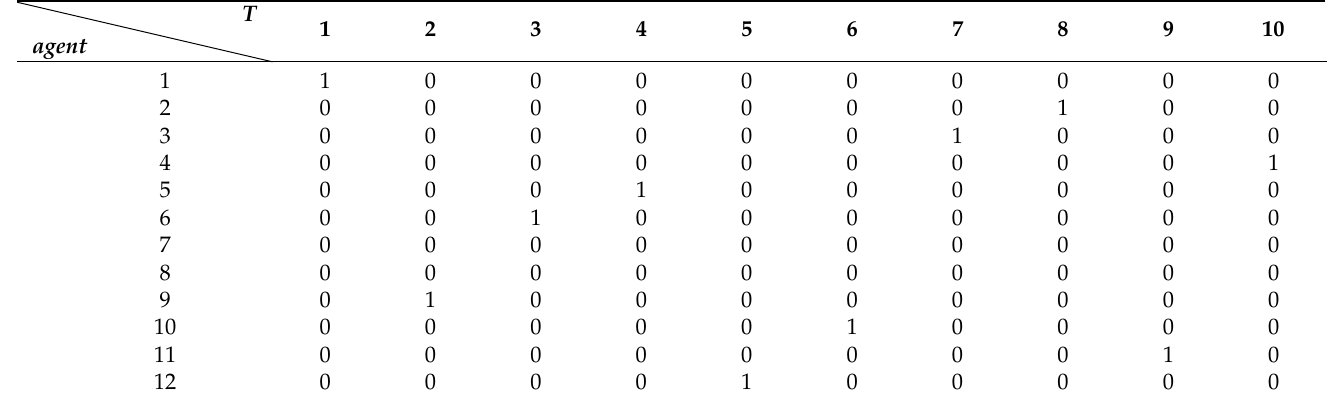
Table of order allocation scheme in parameter analysis. Table A1. Vehicle and cargo resource matching